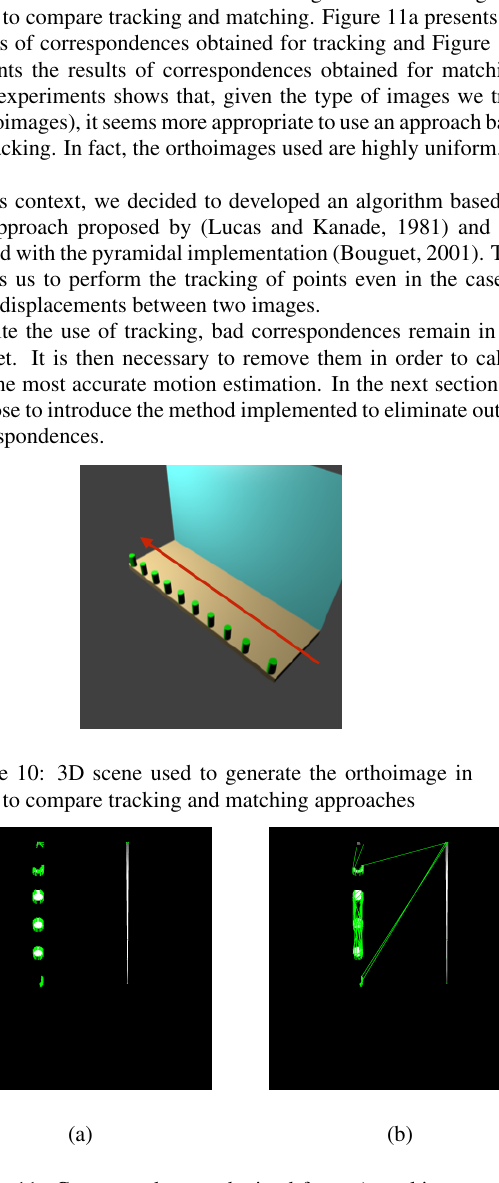
Figure 11: Correspondences obtained for : a) tracking ; and b) matching. The vectors in green represent the calculated corre- spondences